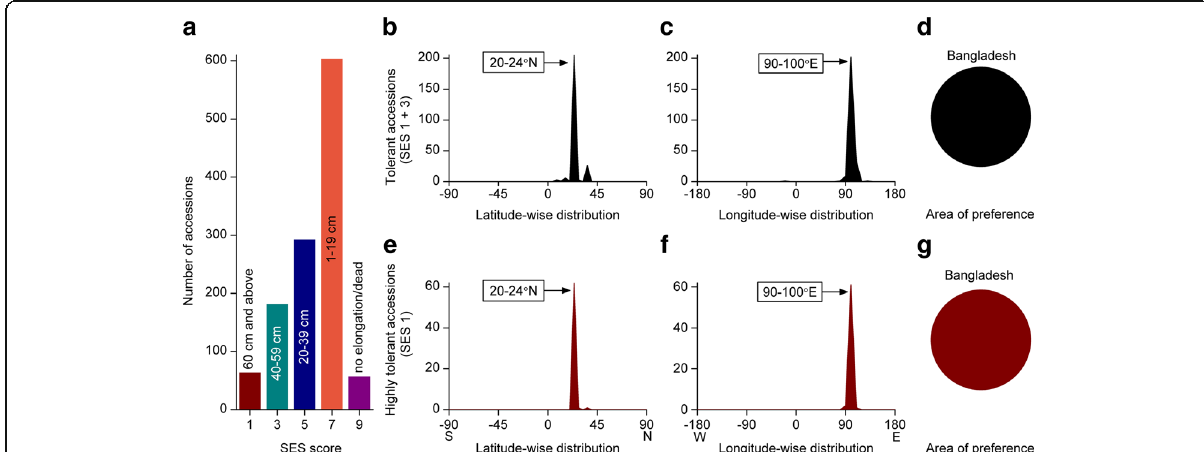
Fig. 4 Geographic distribution pattern of highly elongating (prolong flood tolerant) rice accessions. a Extent of elongation of rice accessions in 1-m water depth, b - d Geographic distribution pattern of 40 cm or above elongating (SES score 1-3) accessions, b Latitude-wise distribution, c Longitude-wide distribution, d Area of preference, e - g Geographic distribution pattern of highly elongating (60 cm and above, i.e., SES 1) rice accessions, e Latitude-wise distribution, f Longitude-wide distribution, g Area of preference. List of highly elongating accessions can be found